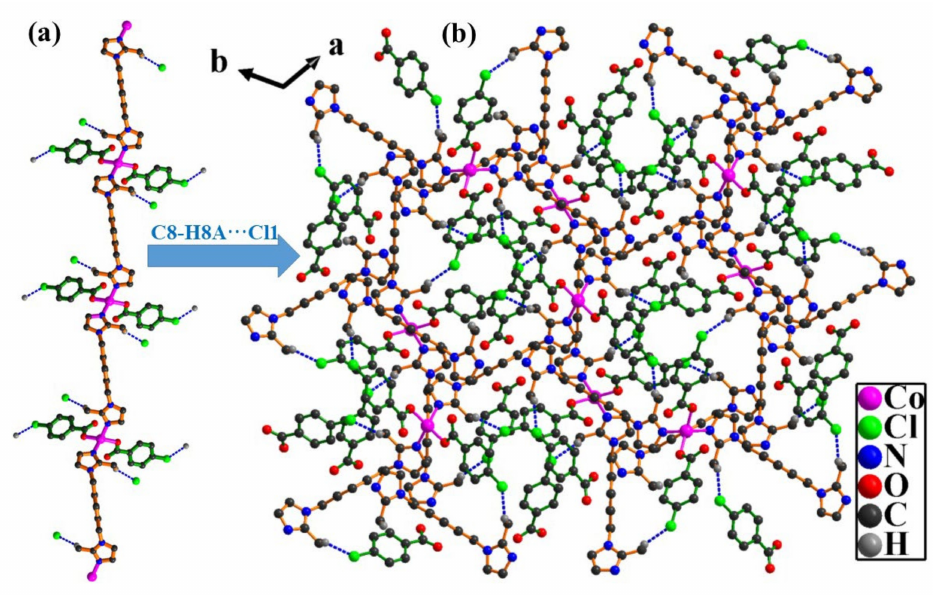
Figure 2. ( a ) The enlarged C8–H8A ··· Cl1 interactions in the 1D chain framework for 1 . ( b ) View of the 3D Co-based hydrogen-bonded framework assembled with C–H ··· Cl interactions in 1 from c